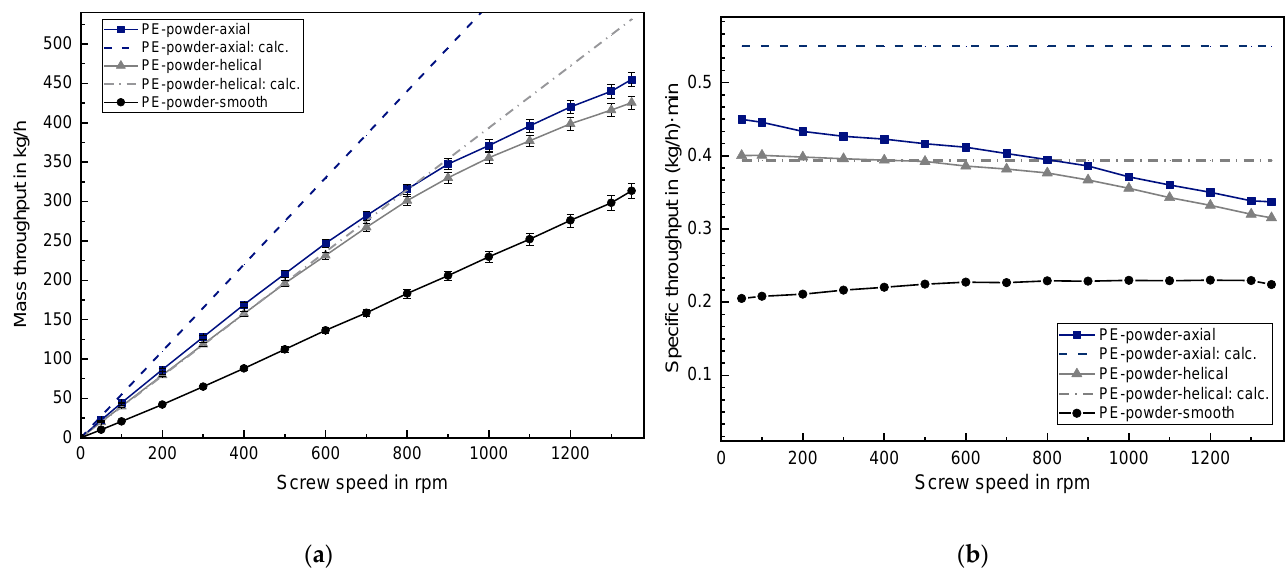
Figure 10. ( a ) Mass throughput and ( b ) specific mass throughput for the powdery PE material.